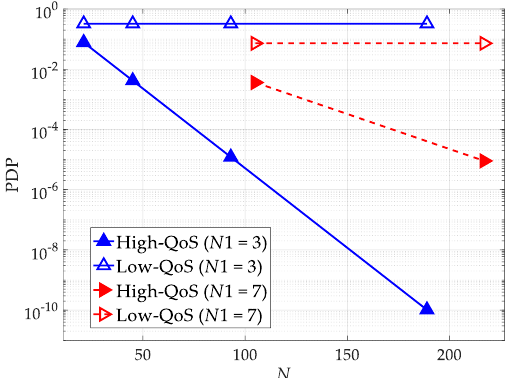
ff ering performance versus CMLS code Figure 9. The PDP of two-level buffering performance versus CMLS code length. Figure 9. The PDP of two-level bu